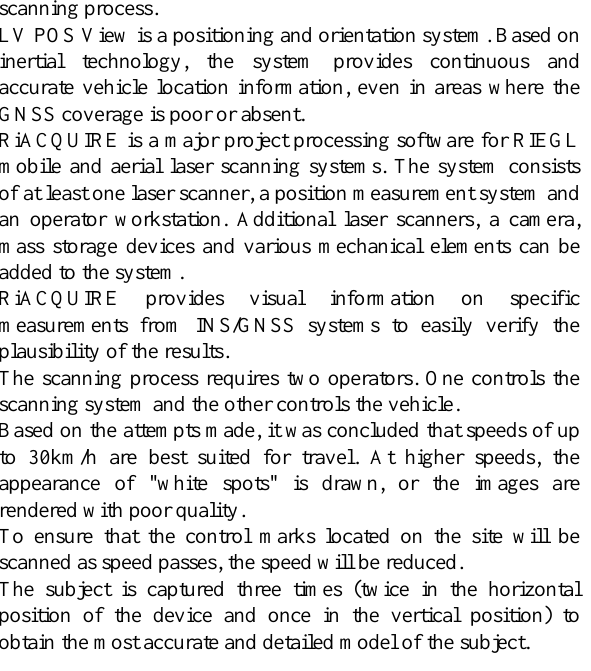
Figure 15: The building in a parcel 68134.902.248